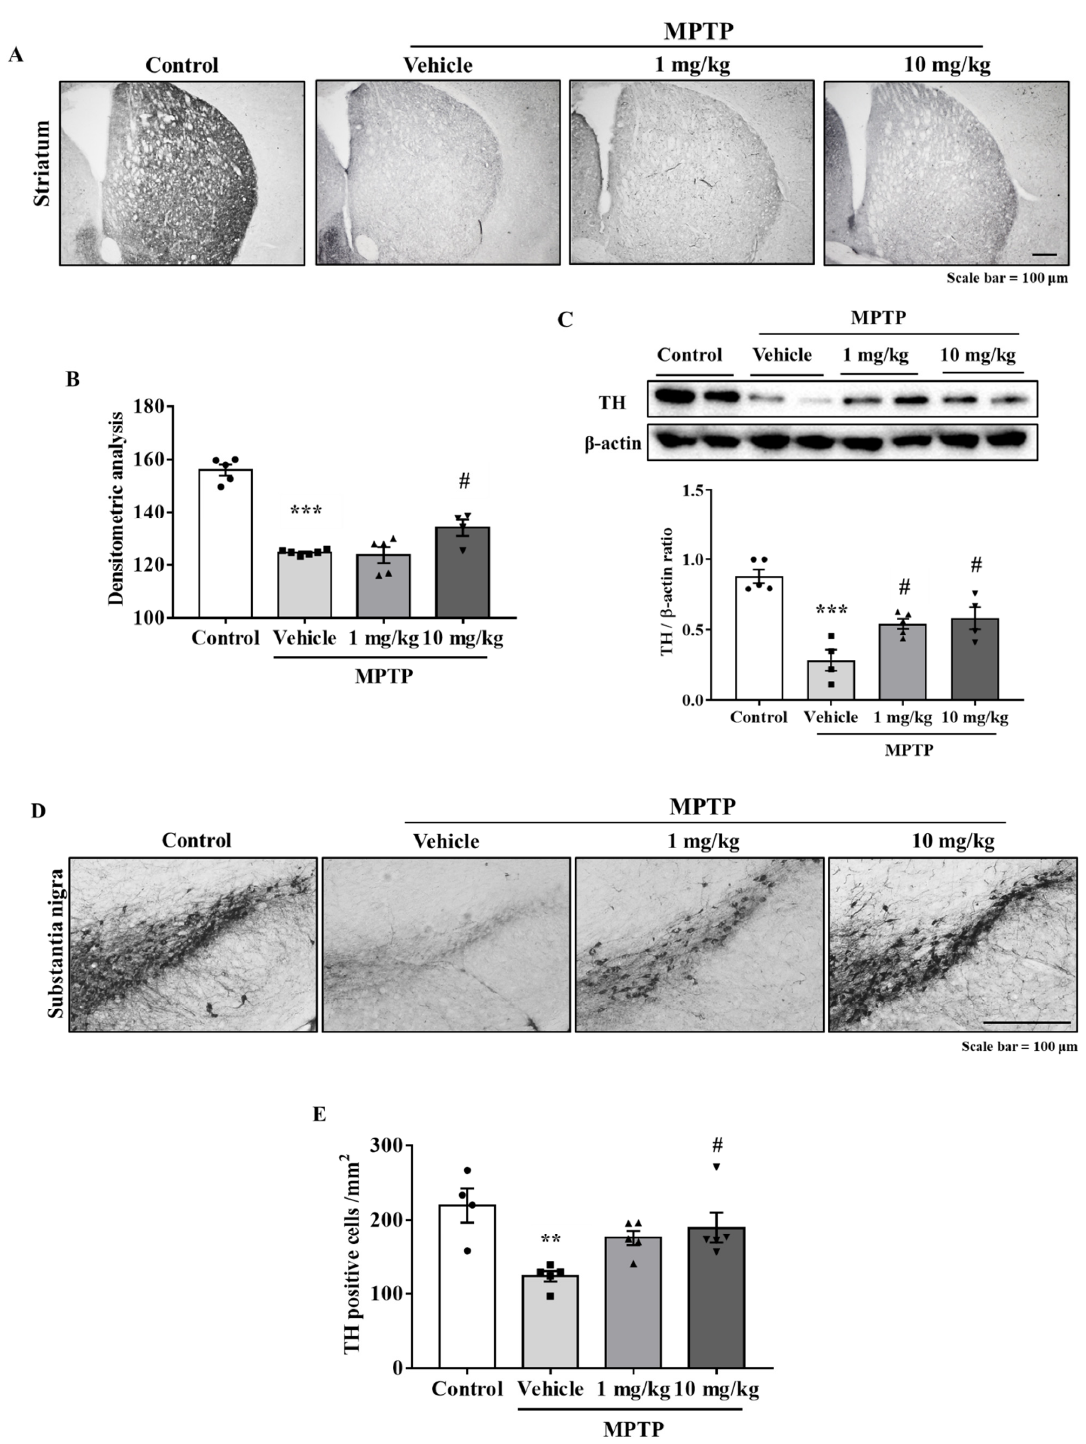
Figure 5. MHY2699 prevented the loss of dopaminergic neurons in the nigrostriatal pathway. ( A , B ) Immunohistochemistry was performed to investigate the neuroprotective effects of MHY2699 in the striatum. Scale bar = 100 µ m. The values are presented as the means ± SEs ( n = 4–6 mice/group). ( C ) MHY2699 significantly elevated the TH levels in STR, as determined by Western blotting ( n = 4–5). ( D , E ) TH-positive cell counts showed that 10 mg/kg at MHY2699 prevented MPTP-induced dopaminergic neuronal loss in SN. Scale bar = 100 µ m. Values are presented as means ± SEs ( n = 4–5 mice/group). *** p < 0.001, ** p < 0.01 vs. the naïve control group, # p < 0.05 vs. the MPTP treated group (as determined by ANOVA with Tukey’s multiple